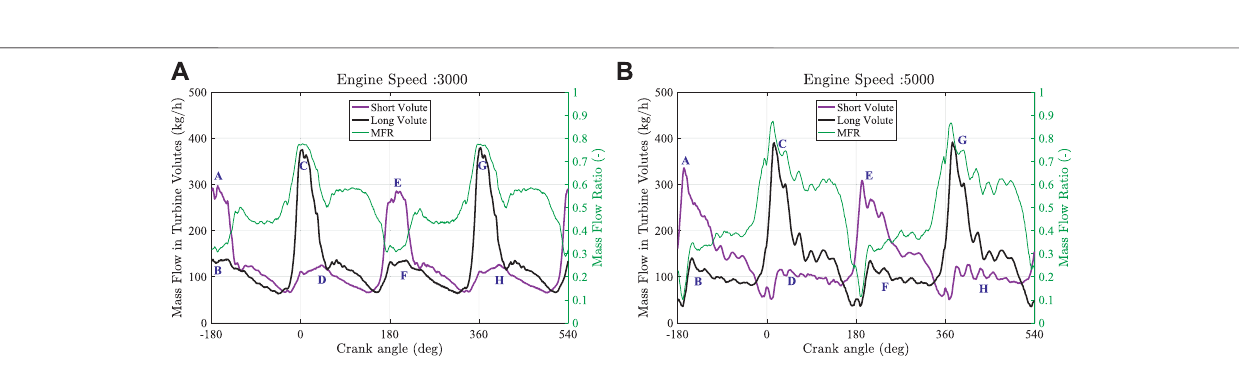
FIGURE 16 | Engine instantaneous mass fl ow rate results from simulation in each turbine branch of the dual-volute turbine. (A) Simulation results of engine speed 3,000; (B) simulation results of engine speed 5,000.